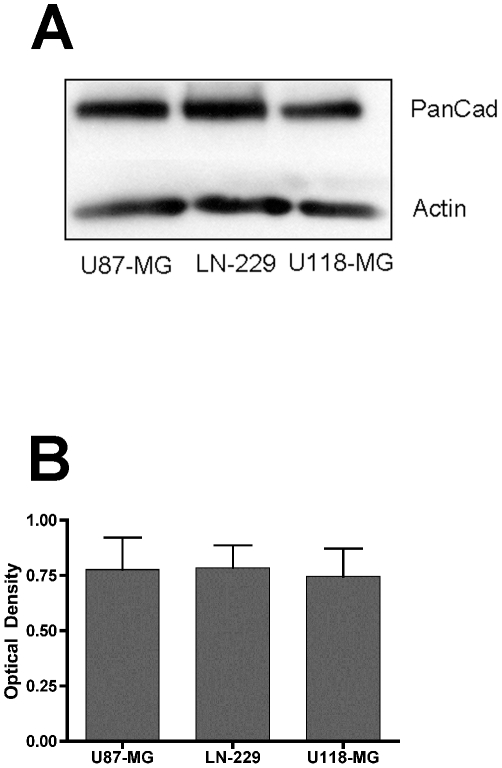
Assessment of pan-cadherin expression by glioma cells.A) Overall cadherin expression by the three cell lines was assessed by immunoblot analysis using a pan-cadherin antibody (clone CH-19, Sigma). Bands, corresponding to the molecular weight of cadherin, are evident. Actin was used as a loading control. B) Quantification of cadherin expression by densitometric analysis. Optical density (OD) of cadherin bands was measured in triplicate as described in the Methods section. These measurements were then normalized by expressing OD of the cadherin signal by that of the corresponding actin signal. Here, the average normalized cadherin OD of the three cell lines is compared. No difference in cadherin expression was detected (ANOVA, p>0.05).